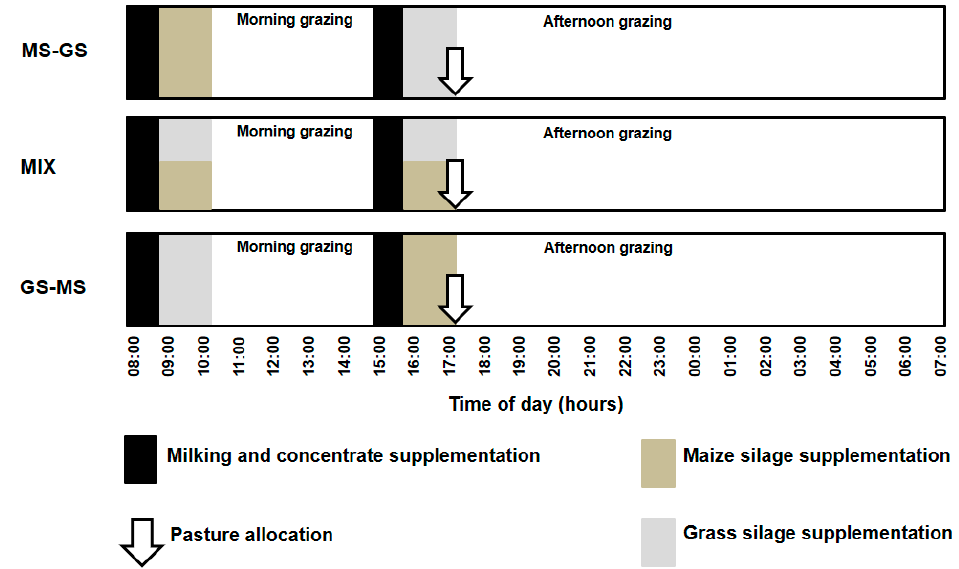
Figure 1. Pasture, grass silage, maize silage and concentrate allocation of treatments. MIX: cows supplemented with 1.5 kg DM of MS and 1.5 kg DM of GS in the morning and again in the afternoon; GS-MS: cows supplemented with 3 kg DM of GS in the morning and 3 kg DM of MS in the afternoon; MS-GS: cows supplemented with 3 kg DM of MS in the morning and 3 kg DM of GS in the